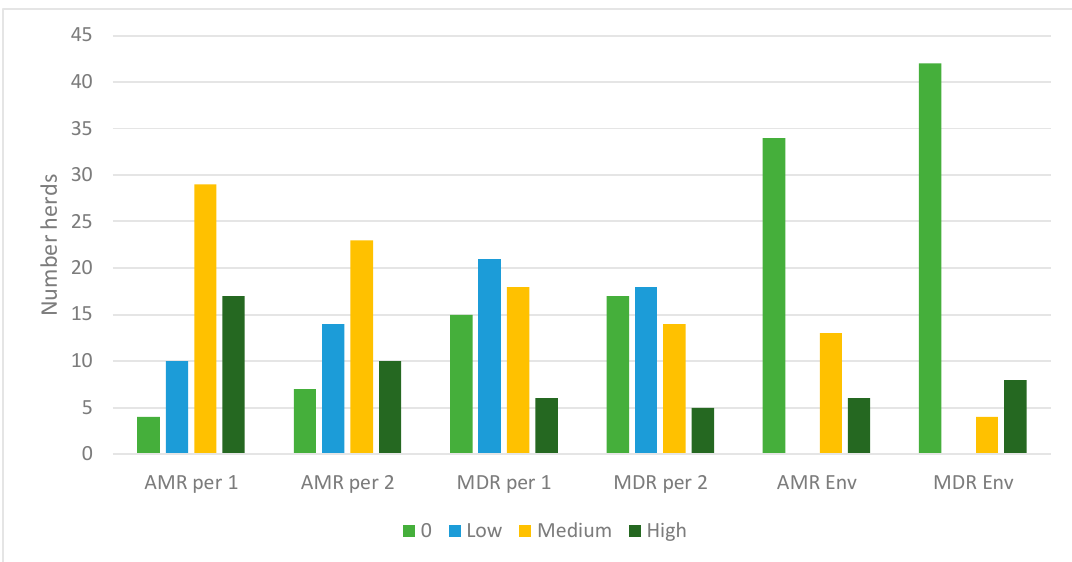
Figure 4. Number of sampled herds with zero (0), low (1–25%), medium (26–60%) and high (>60%) proportions of Escherichia coli with antimicrobial resistance to any antimicrobial class (AMR) or to three or more antimicrobial classes (MDR) in Swedish organic and conventional dairy herds. Isolates from calf samples in period 1 (per 1) and period 2 (per 2) and environmental samples in period 2 (env).